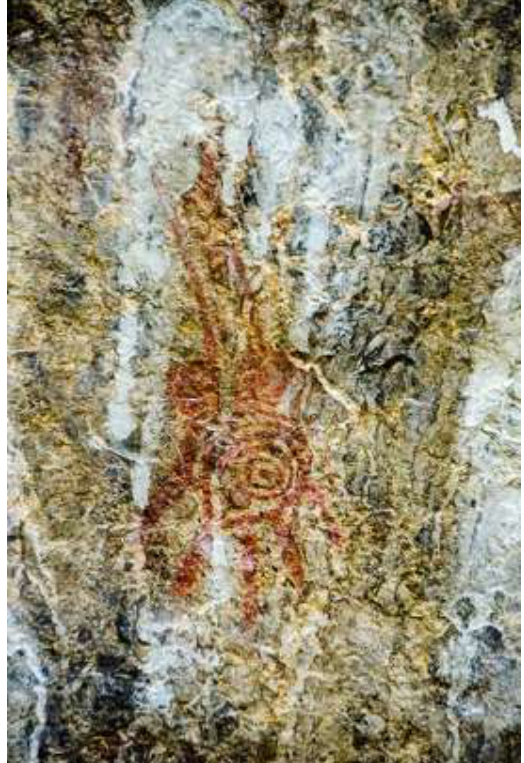
Figure 5. A stylised human hand is one of the many paintings from Padalin Cave 1 in Shan State. Photo: Noel H.